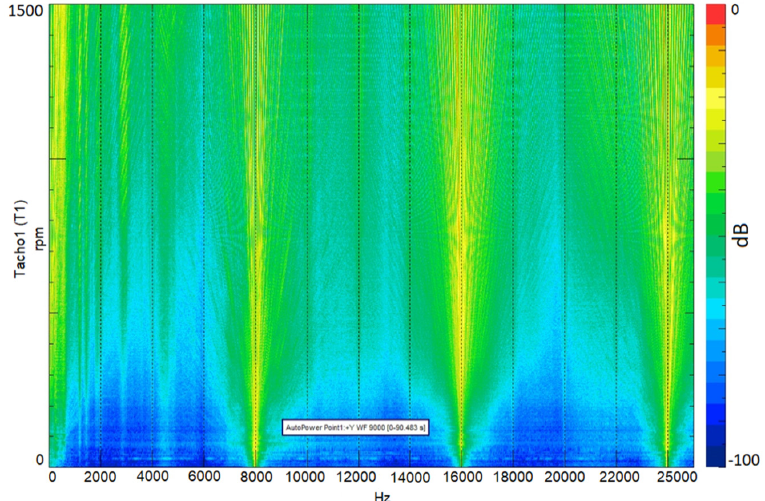
Figure 12. Vibration measured at 8 kHz switching frequency .